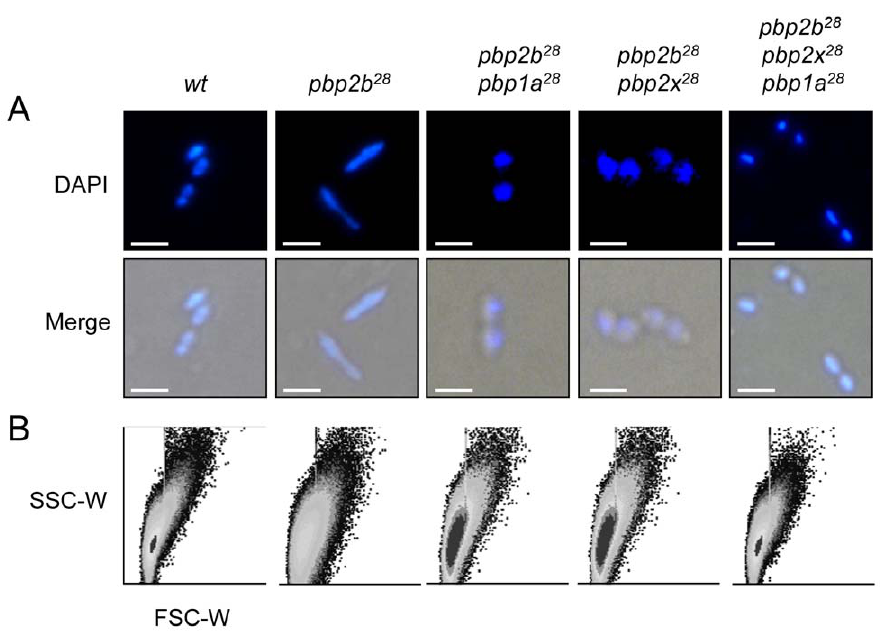
Figure 2. Effect of pbp mutations on cell morphology. Cells were prepared for microscopy and stained with DAPI as described in Materials and Methods (bar scale, 5 m m). (A) Merged phase-contrast and DAPI fluorescence image of the pbp mutants showing a bacillar morphology, contrasting with the typical coccoid shape of the CP1015 ( wt ) strain. (B) Cell shape modifications of the cell populations detected by flow cytometry analysis. Exponentially growing bacterial cells were injected into a flow cytometer and the results were analyzed with the WinMDI software. To compare populations, the data for each strain were plotted on a two-dimensional graph ( x -axis, forward scatter; y -axis, side scatter).